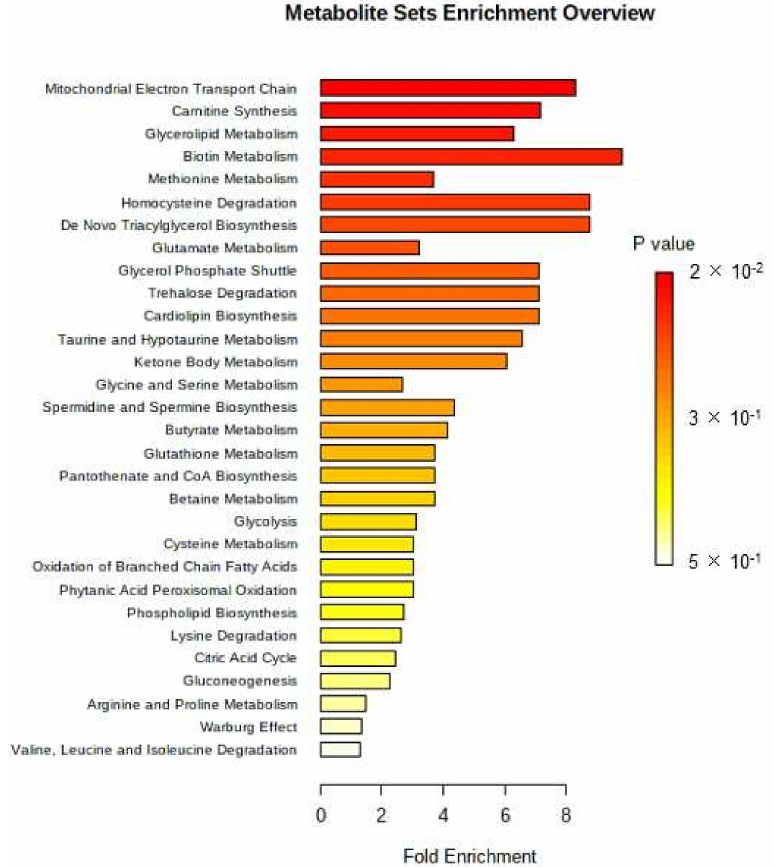
Figure 3. Results of the Metabolite Set Enrichment Analysis with Fold Enrichment higher than